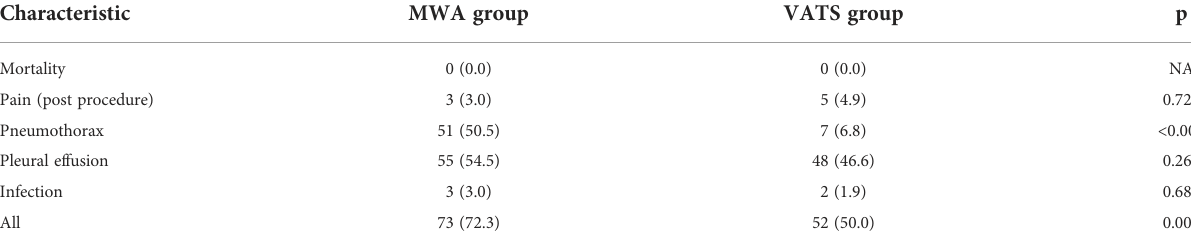
TABLE 3 The complications of enrolled